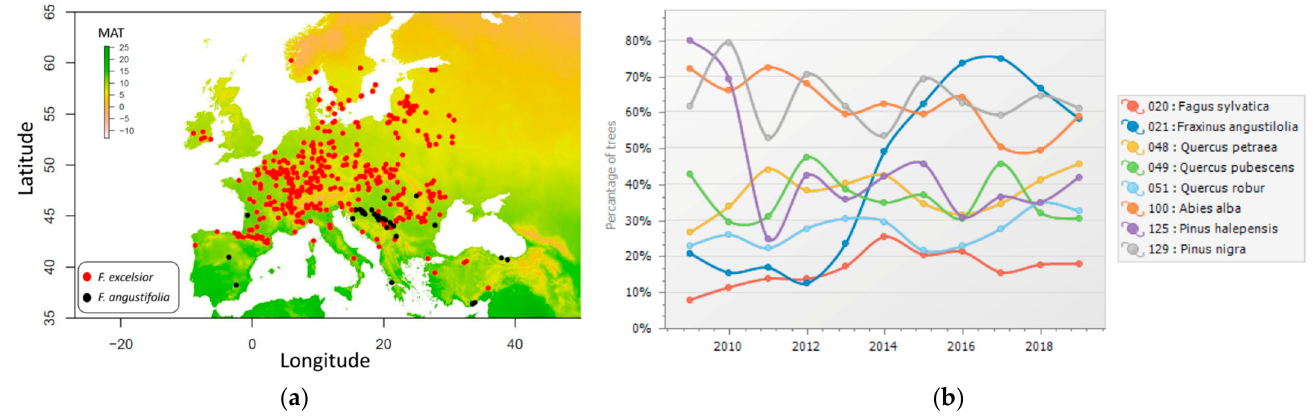
Figure 3. ( a ) Overview of analysed survey plots from the ICP Forests Level I dataset (source: [13]) and ( b ) overview of significant defoliation (>25%) of canopy of some species of forest trees in the Republic of Croatia for the period 2009–2019 (source: [19]).